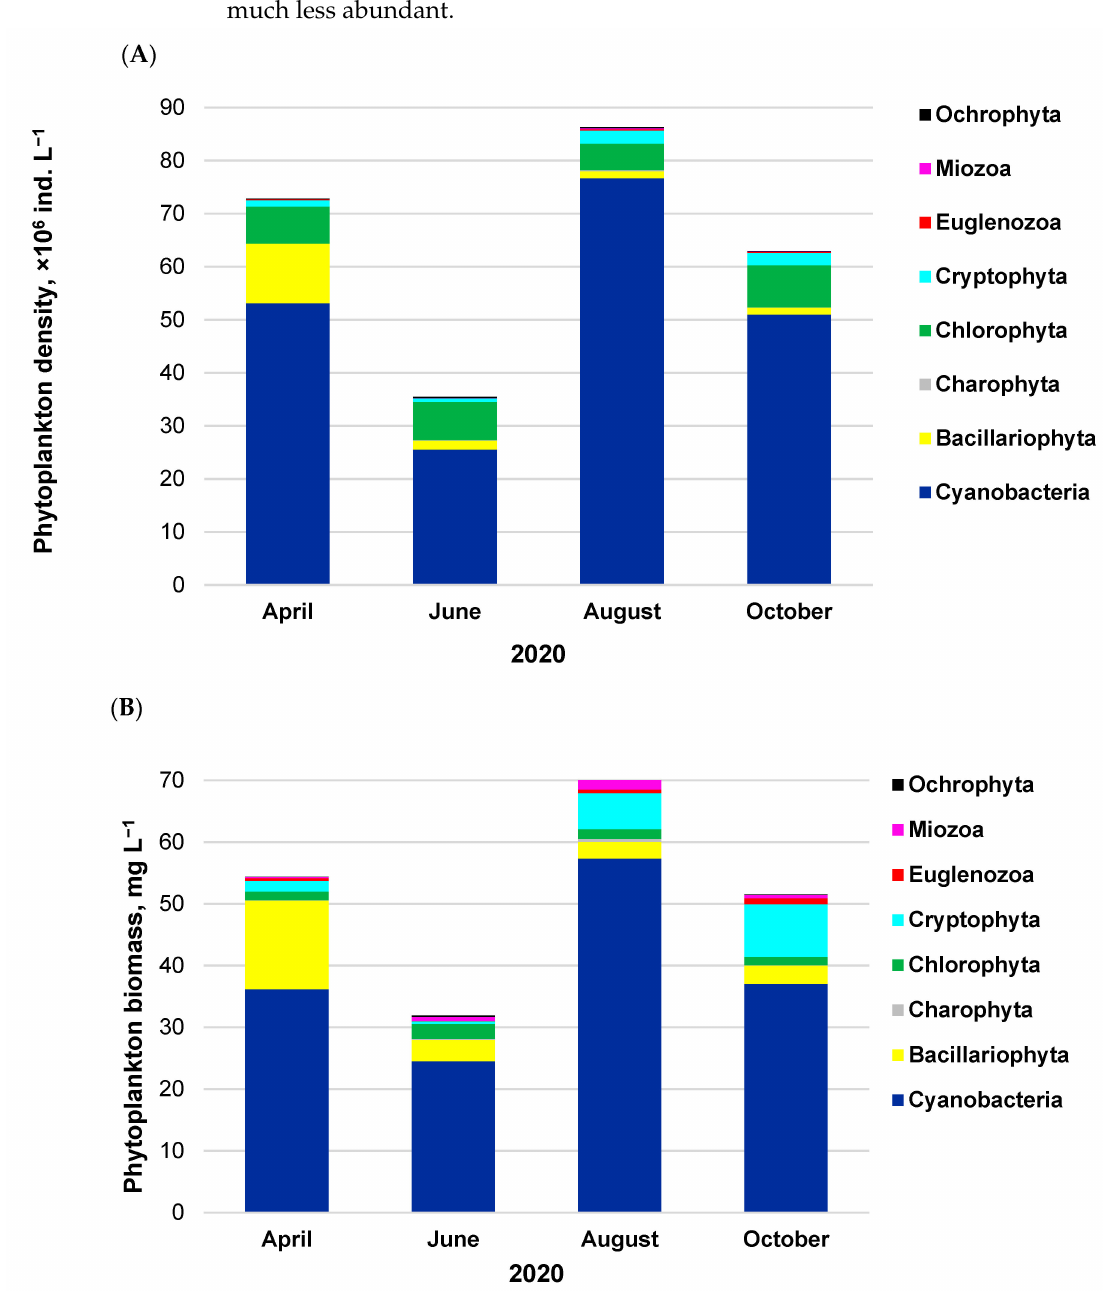
Figure 2. Phytoplankton density ( A ) and biomass ( B ) in Lake Sztynorckie (representative site in profundal zone S1) with an emphasis on each taxonomic